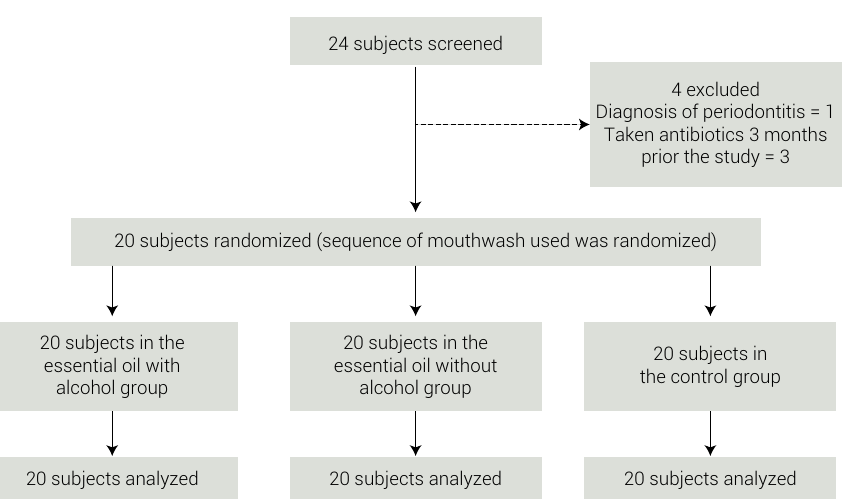
Figure 1. Flowchart of the participants in the study.